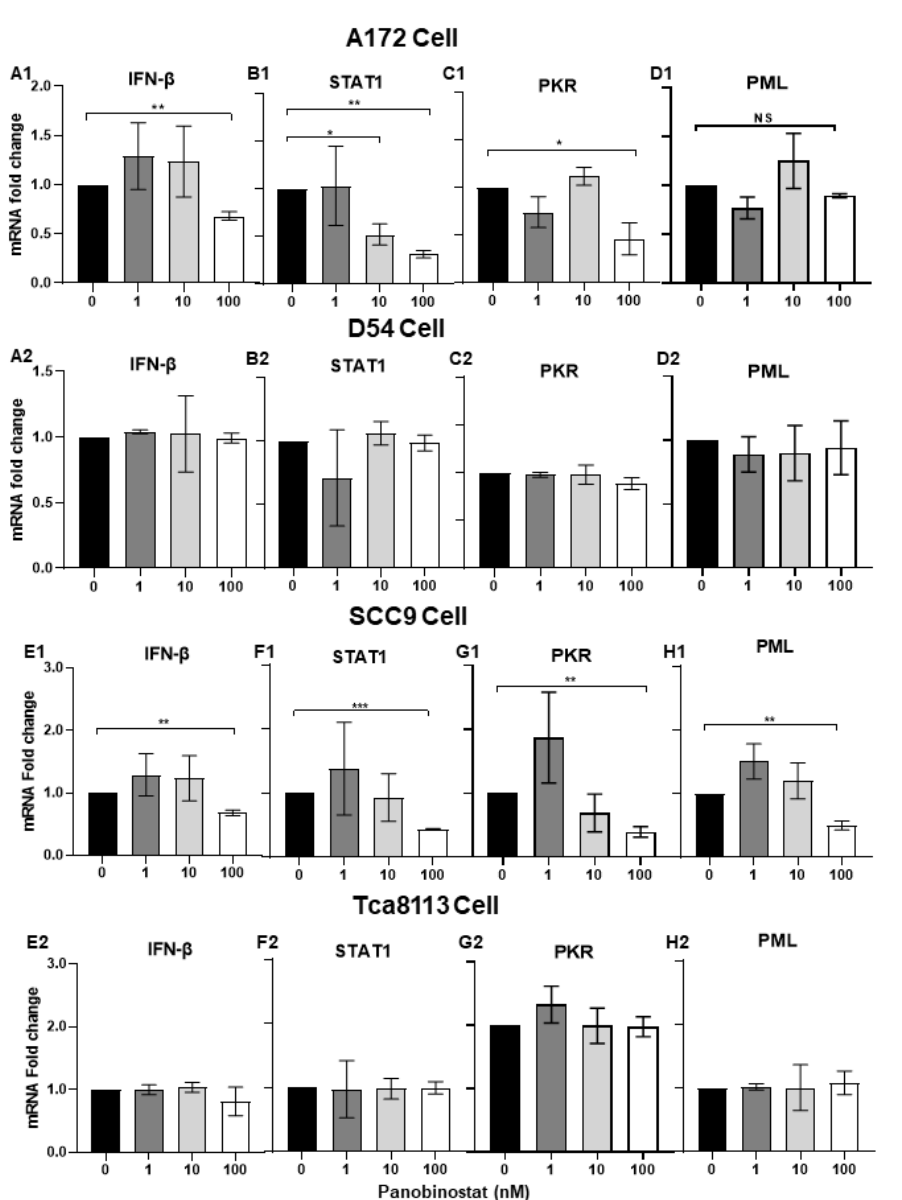
Figure 3. Downregulation of IFN- β - and IFN-stimulated antiviral genes when treated with pano- binostat in human glioma and squamous cell carcinoma cells. A172 ( A1 , B1 , C1 , D1 ), D54 ( A2 , B2 , C2 , D2 ), SCC9 ( E1 , F1 , G1 , H1 ), or Tca8113 ( E2 , F2 , G2 , H2 ) cells were mock-treated or treated with panobinostat at different concentrations of 1, 10, or 100 nM for 14 h, respectively. Then, the cell pellets were harvested and total RNAs were extracted and reverse-transcribed to cDNA as described in the Materials and Methods section. The IFN- β , STAT1, PKR, and PML mRNAs were quantified and normalized with respect to 18S rRNA and are shown as fold changes compared to the mRNAs from the mock-treated and infected cells. Differences between datasets were assessed by Student’s t -test (two-tailed) using GraphPad Prism software. NS p >0.05, * p < 0.05, ** p < 0.01, *** p < 0.001.